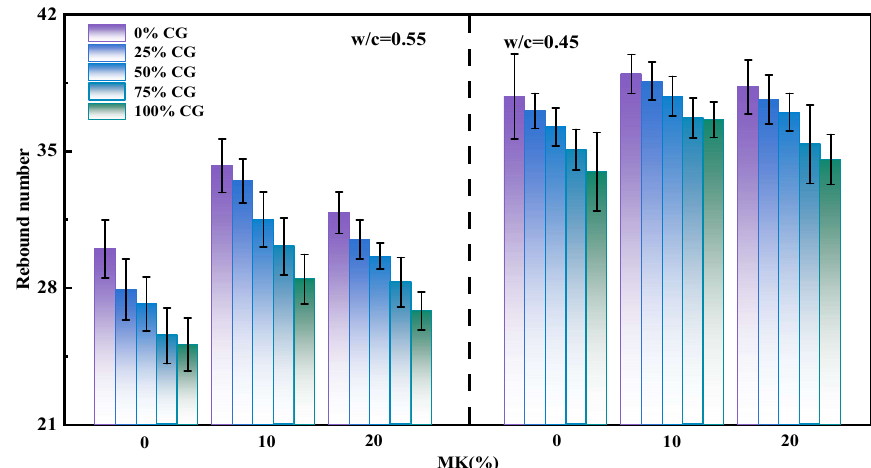
Figure 4. Variation of rebound number.